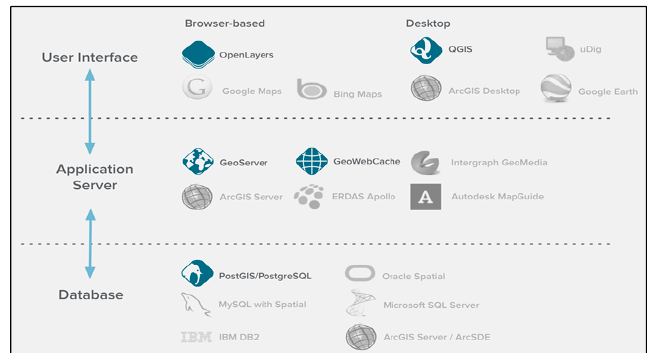
Figure 9. Hierarchical relationship of the OpenGeo Suite series software.